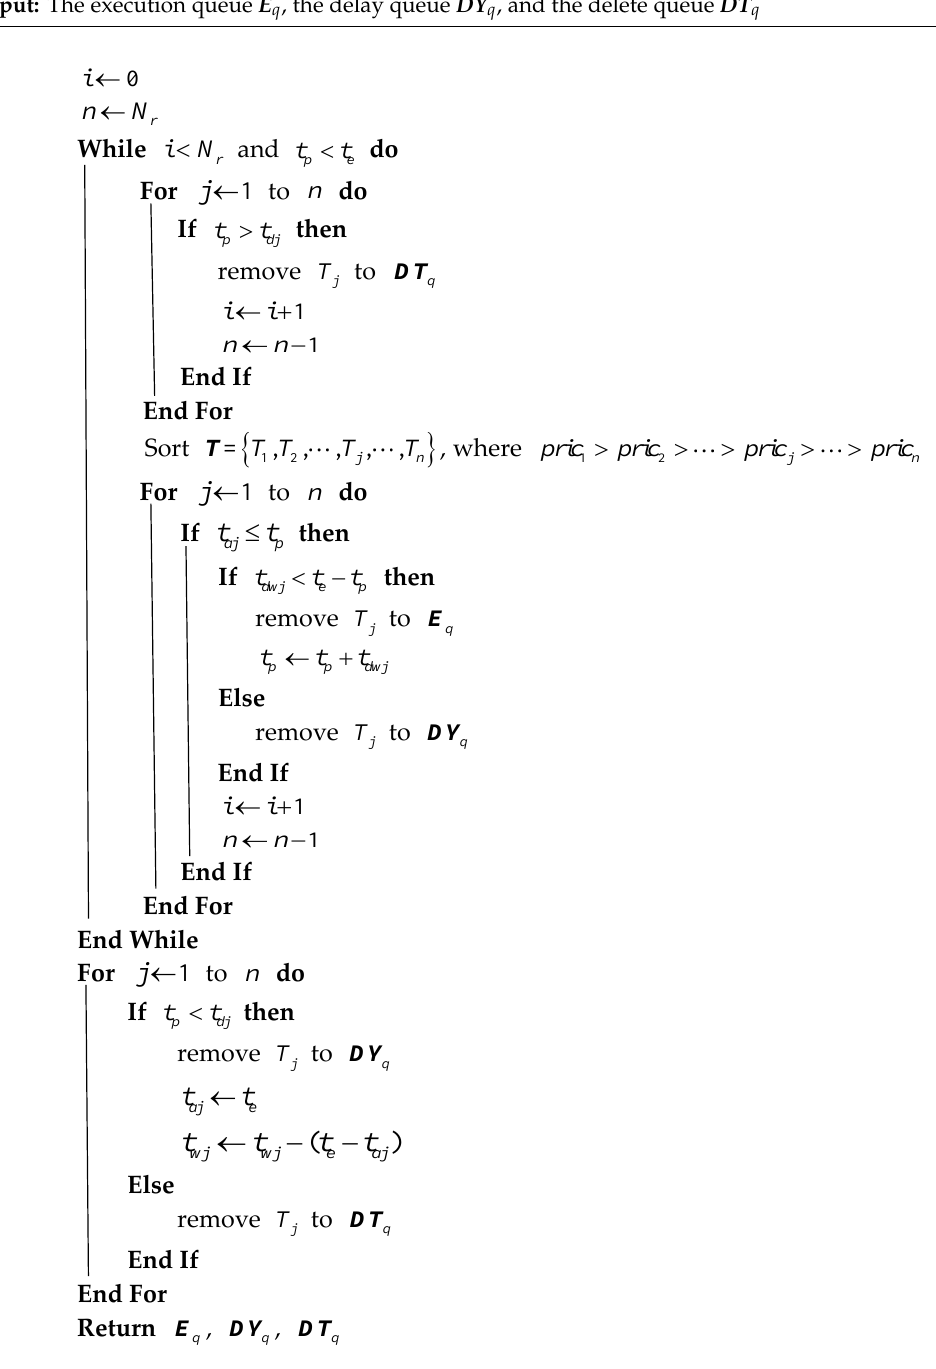
Algorithm 2: The radar scheduling